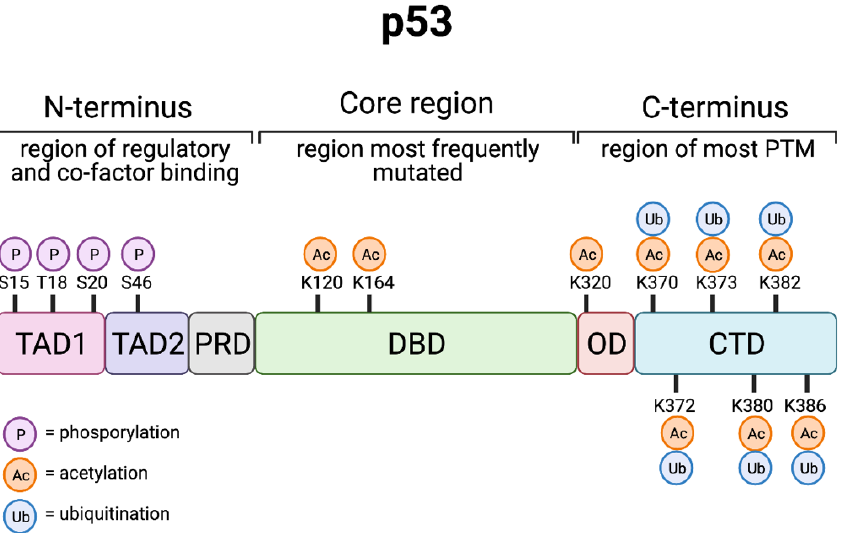
Figure 1. p53 structure and post-translational modification. Schematic representation of distinct p53 domains and the key post- translational modifications which have been shown to regulate p53 activity; transactivation domain (TAD1 and TAD2), proline-rich domain (PRD), DNA-binding domain (DBD), oligomerisation (OD), and the C-terminal domain (CTD). Created with BioRender.com (accessed on 15 May 2021).